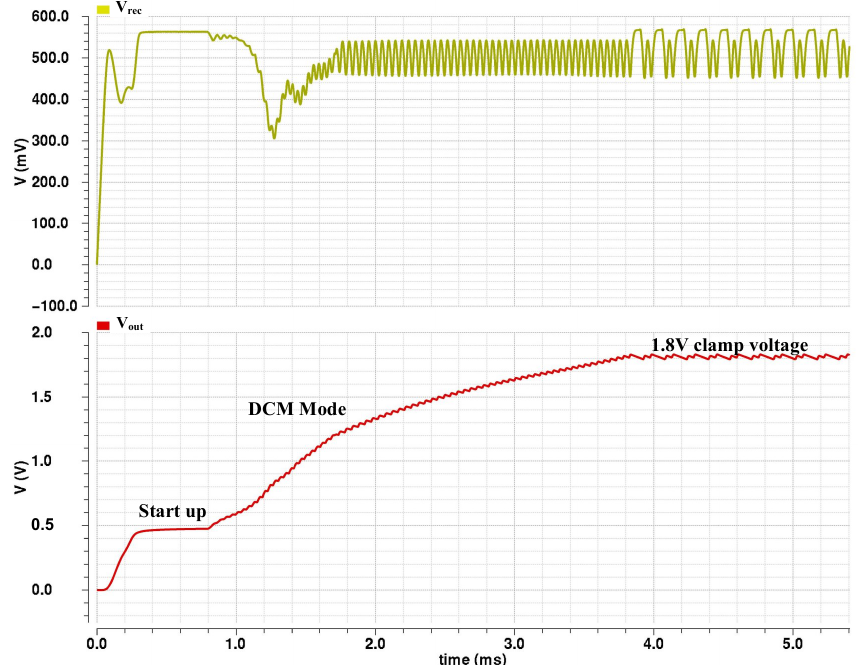
Figure 20. Simulated timing waveforms of DC-DC boost